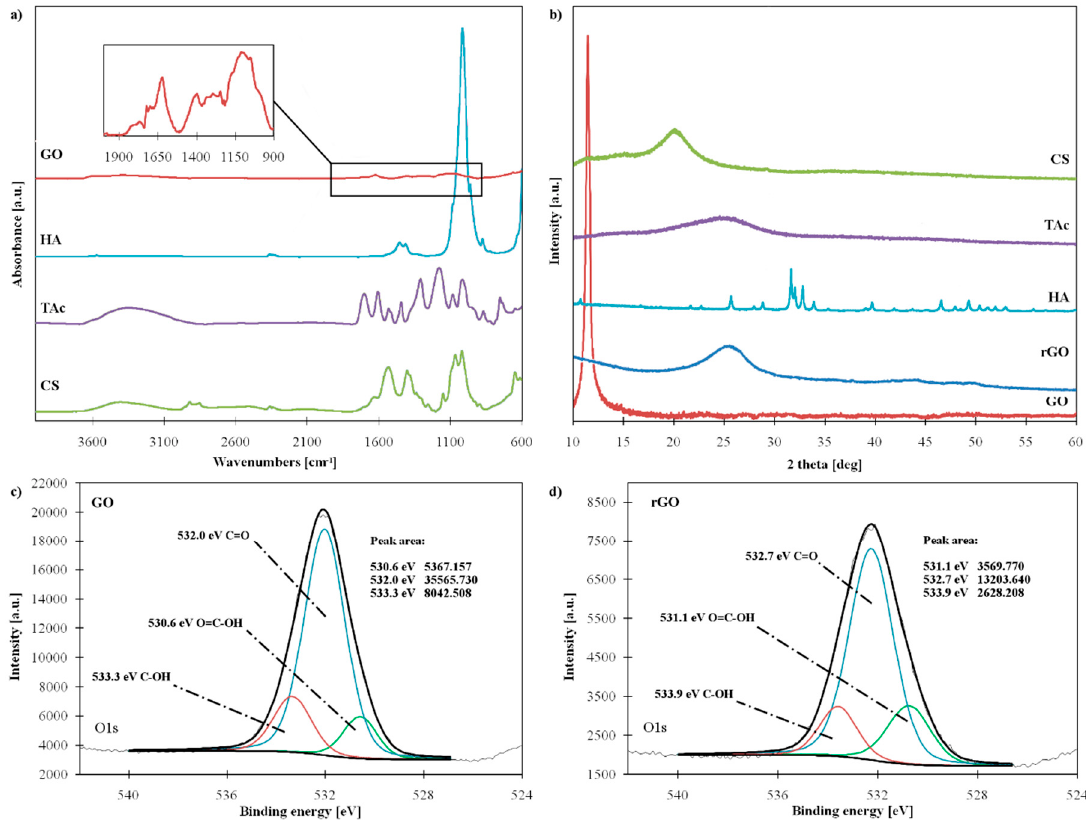
Figure 1. ( a ) ATR-FTIR (Attenuated Total Reflection Fourier-Transform Infrared) spectra, ( b ) XRD (X-Ray Diffractometry) patterns of materials used for chitosan (CS) nanocomposites synthesis, and XPS (X-ray Photoelectron Spectroscopy) spectra of ( c ) graphene oxide (GO) and ( d ) reduced graphene oxide (rGO); (HA—hydroxyapatite, TAc—tannic